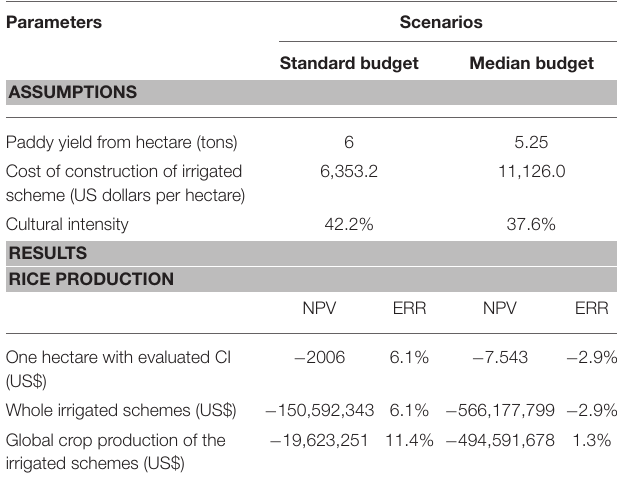
TABLE 4 | Base and median value inputs